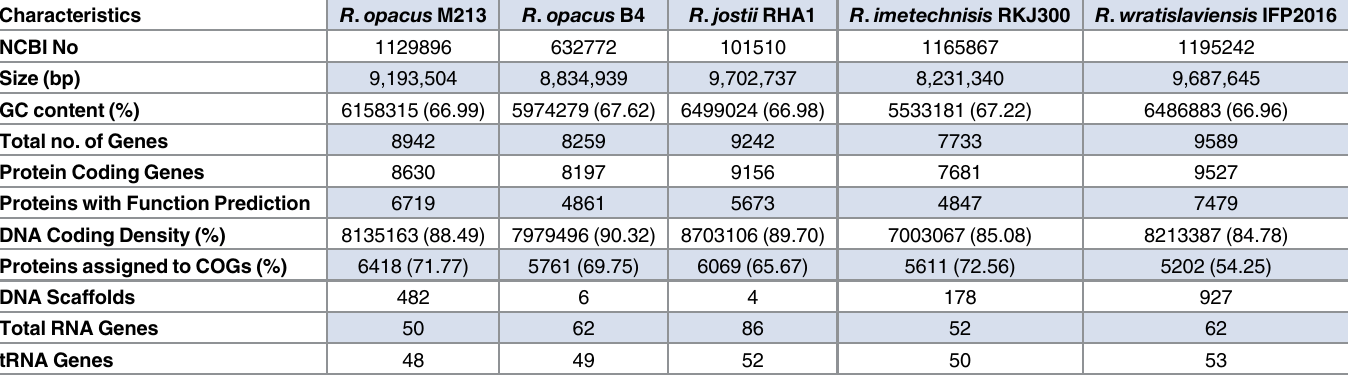
Table 1. General features of the genomes of Rhodococcus species that were found to be functionally close to R . opacus strain M213 in this study. Characteristics